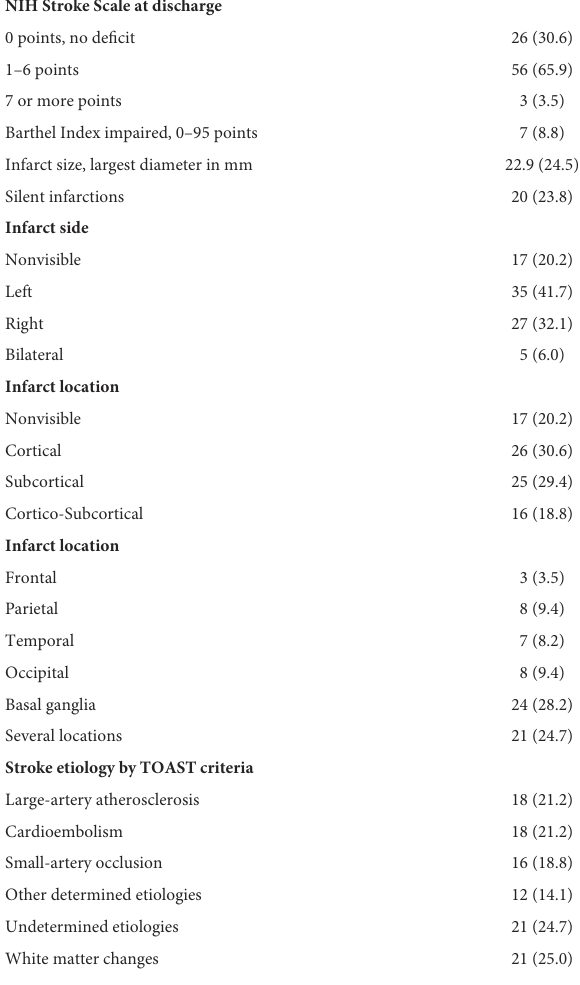
TABLE 1 Ischemic stroke characteristics at the time of the incident stroke for 85 stroke patients included in this